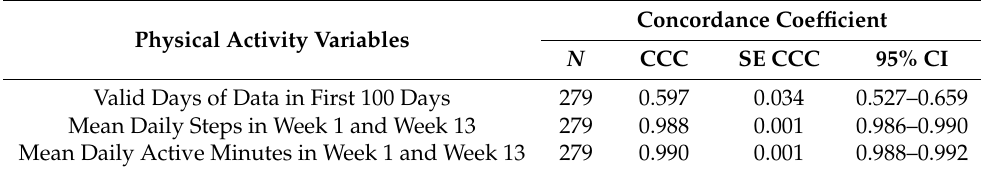
Table 3. Concordance between Step Count- and Heart Rate-derived physical activity outcomes among participants with valid data.